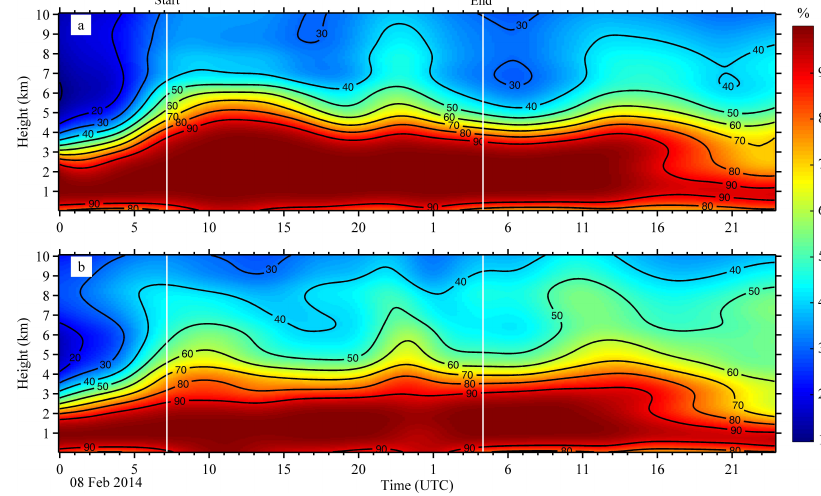
Figure 9. Same as Fig. 7 but for relative humidity retrievals.